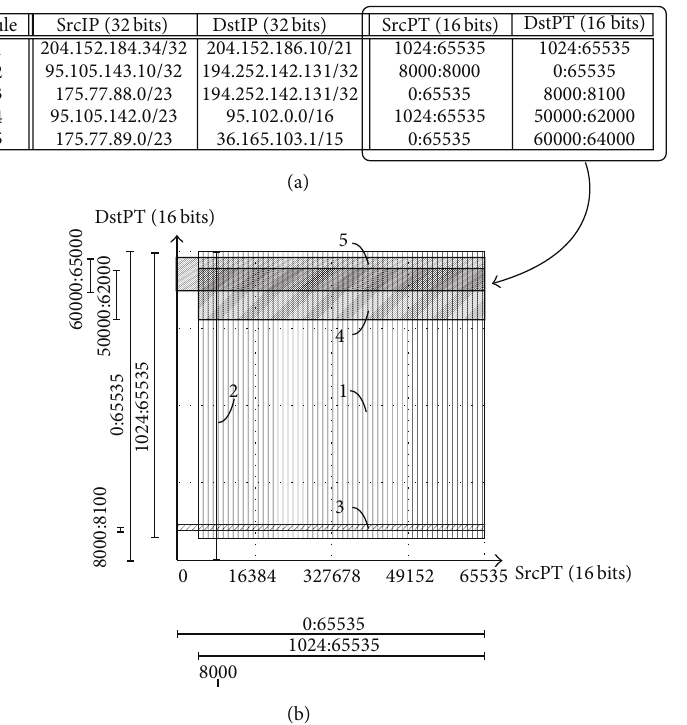
Figure 1: Real ruleset: (a) table of rule specifications and (b) geometric view of application-level fields